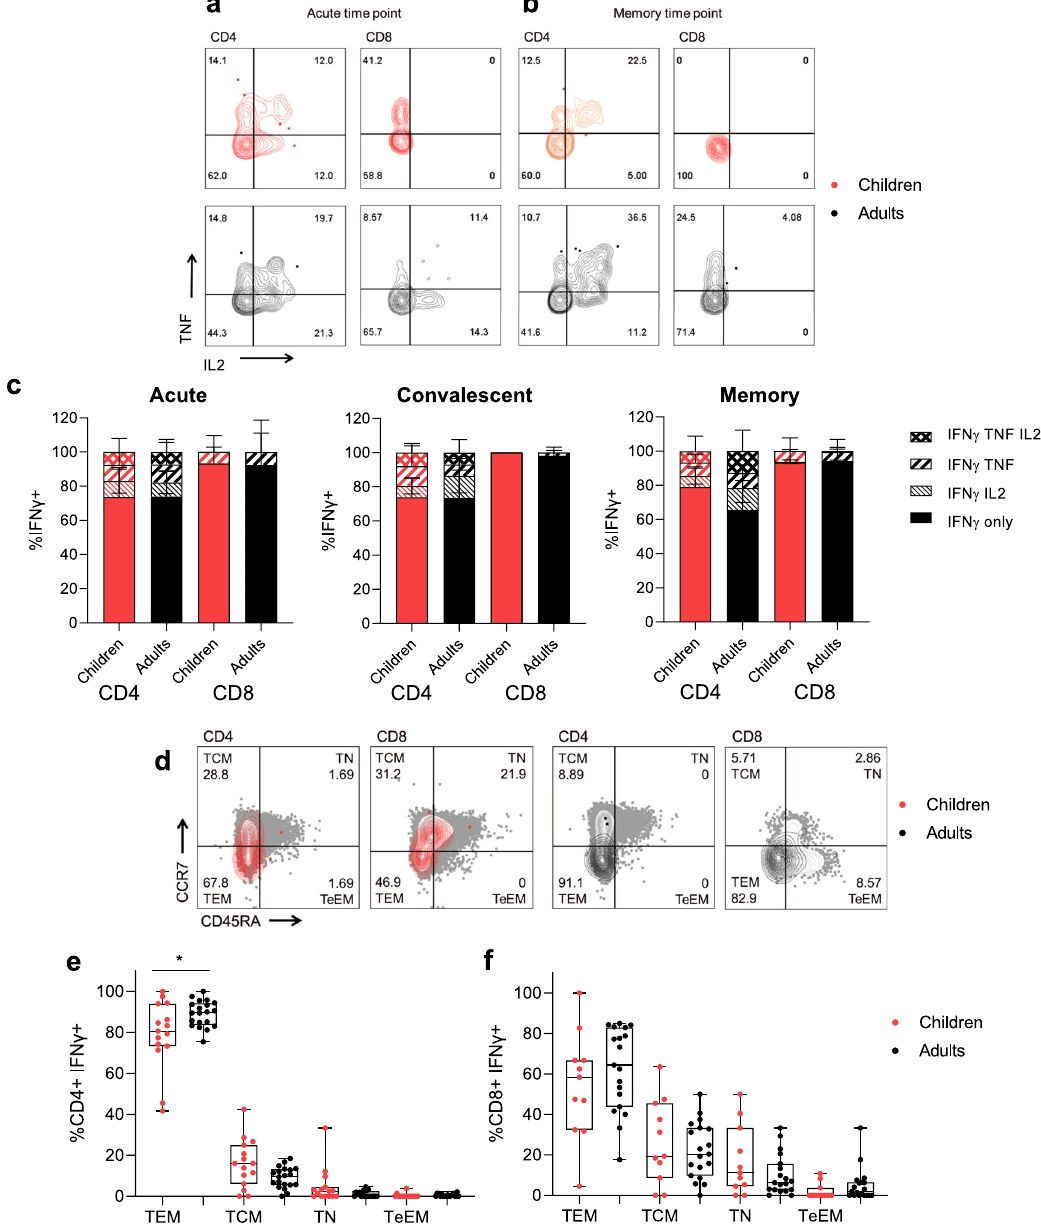
Fig. 6 Cytokine polyfunctional quality and memory phenotype. Representative FACS plots of TNF and IL2 producing IFN γ + CD4 + and CD8 + T cells of children (red) and adults (black) at acute (d < 14) ( a ) and memory (child: 118 days, adult: 94 days) ( b ) time points. ( c ) The proportion of IFN γ producing CD4 + and CD8 + T cells which are single, double, or triple cytokine producers at acute (< 14 days), convalescent (15 – 60 days), or memory (61 – 180 days) time points post symptom onset. Bars represent the mean values in infected children and adults, while error bars represent SD. Kruskal – Wallis test for multiple comparisons was carried out to compare each group between children and adults. d Representative FACS plots showing memory phenotypes of IFN γ + CD4 + and CD8 + T cells based on the expression of CCR7 and CD45RA. Sections are T effector memory (TEM), central memory (TCM), terminal effector memory (TeEM), or naïve (TN). Memory phenotype responses in IFN γ + CD4 + ( e ) and CD8 + ( f ) T cells of responders at later time points (15 – 180 days post symptom onset). Data shows individual values, box and whiskers plots median, upper and lower quartiles, minimum and maximum values. Comparisons between children ( n = 15) and adults ( n = 20) in each group were performed using the Mann – Whitney test, ( e ) * p = signi fi cant correlation of OC43-IgG responses with age (Fig. 7d) and adult negative controls (Fig. 7a), whilst β -coronavirus HKU-1 ( r = 0.6466, p = 0.0002). However, there was no direct signi fi cant and OC43-speci fi c IgG was signi fi cantly lower in infected chil- correlation between OC43-IgG responses and structure-speci fi c dren than infected adults (Fig. 7b). Furthermore, there was no CD4 + ( p = 0.1027, Fig. 7e) or CD8 + T cells ( p = 0.9729, Fig. 7f). However, there was a borderline moderate negative correlation difference in OC43-IgG responses between symptomatic or between OC43-IgG and early acute activated Tfh responses asymptomatic infections, with signi fi cance only being seen (Fig. 7h) ( r = − 0.3326, p = 0.0779) 15 . between symptomatic adults and children (Fig. 7c). There was a